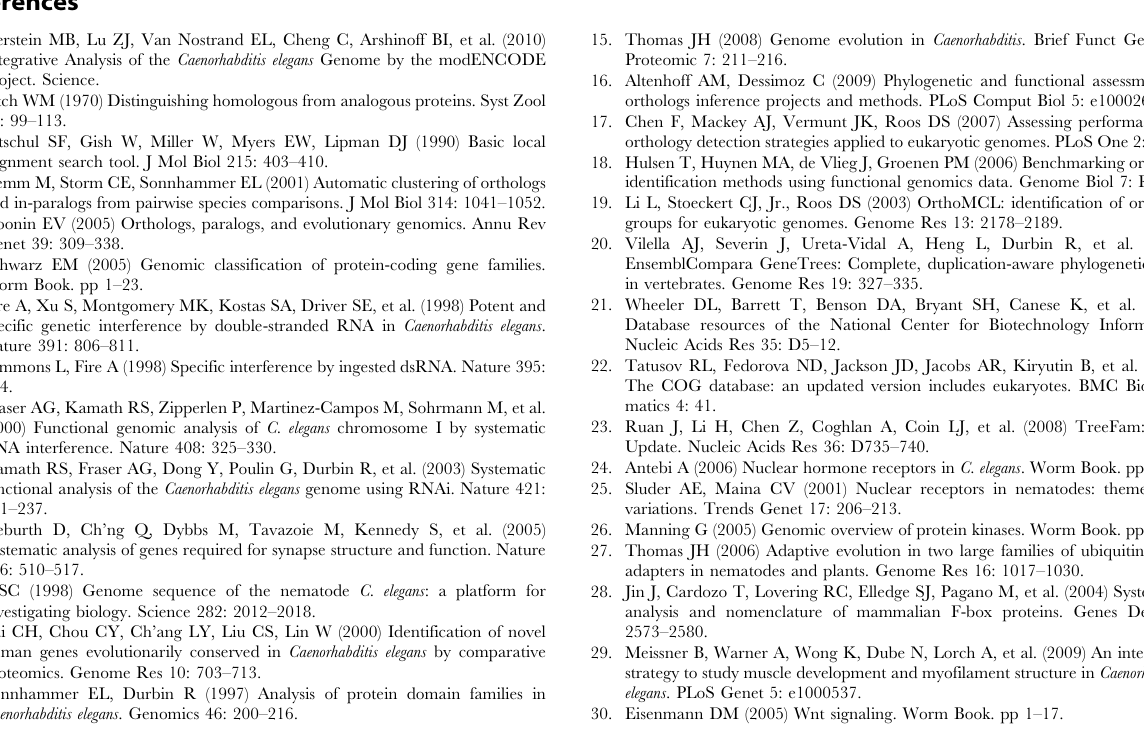
and their associated annotations. This is source data for pivot reports in Tables S10A, B. Table S11 Biological process (bp) GO annotations of OrthoList. A) Gene-focused pivot report. B) bp-focused pivot report. C) All OrthoList genes with bp GO annotations (6,951/7,633, or , 77%), and their associated annotations. This is source data for pivot reports in Tables S11A, B. Table S12 Cellular component (cc) GO annotations of Ortho- List. A) Gene-focused pivot report. B) cc-focused pivot report. C) All OrthoList genes with cc GO annotations (4,313/7,633, or , 56%), and their associated annotations. This is source data for pivot reports in Tables S12A, B. Table S13 Molecular function (mf) GO annotations of Ortho- List. A) Gene-focused pivot report. B) mf-focused pivot report. C) All OrthoList genes with mf GO annotations (5,269/7,633, or , 69%), and their associated annotations. This is source data for pivot reports in Tables S13A,